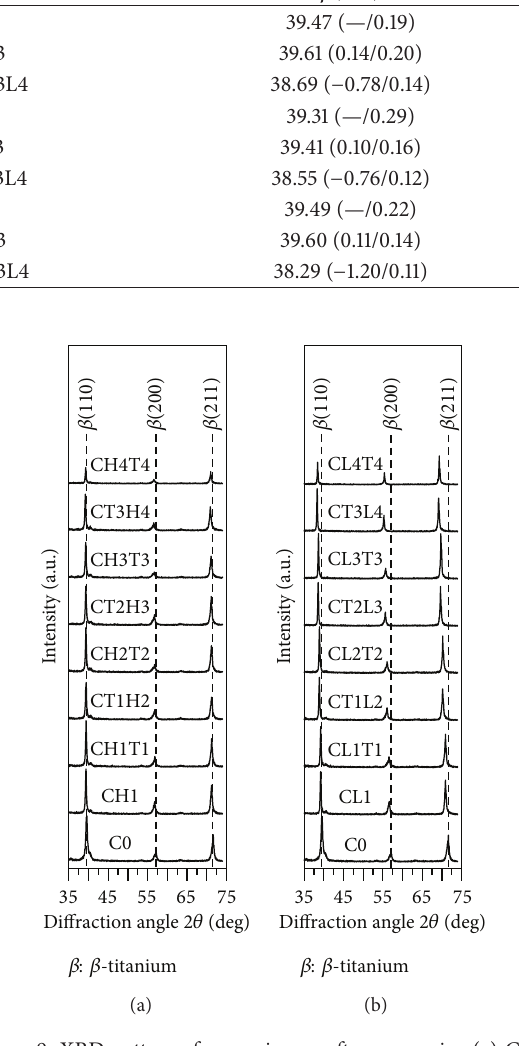
Figure 9: XRD patterns for specimens after successive (a) CH j T l and (b) CL j T l treatments.